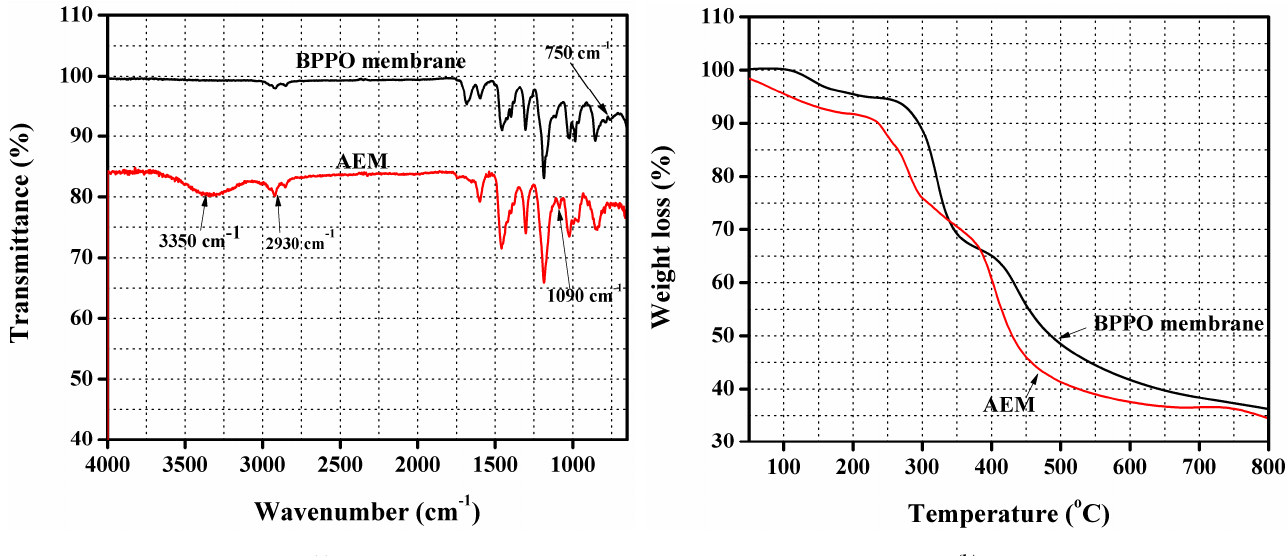
Figure 1. ( a ) IR spectrums of pure brominated of poly(2,6-dimethy-1,4-phenyleneoxide) (BPPO) as well as the dimethylethanolamine (DMEA)-grafted anion exchange membrane authenticating successful synthesis of the DMEA-grafted anion exchange membrane (AEM). ( b ) thermogravimetric analysis (TGA) thermograms of the pure BPPO membrane and DMEA-grafted AEM, indicating higher thermal stability of the DMEA-grafted AEM.